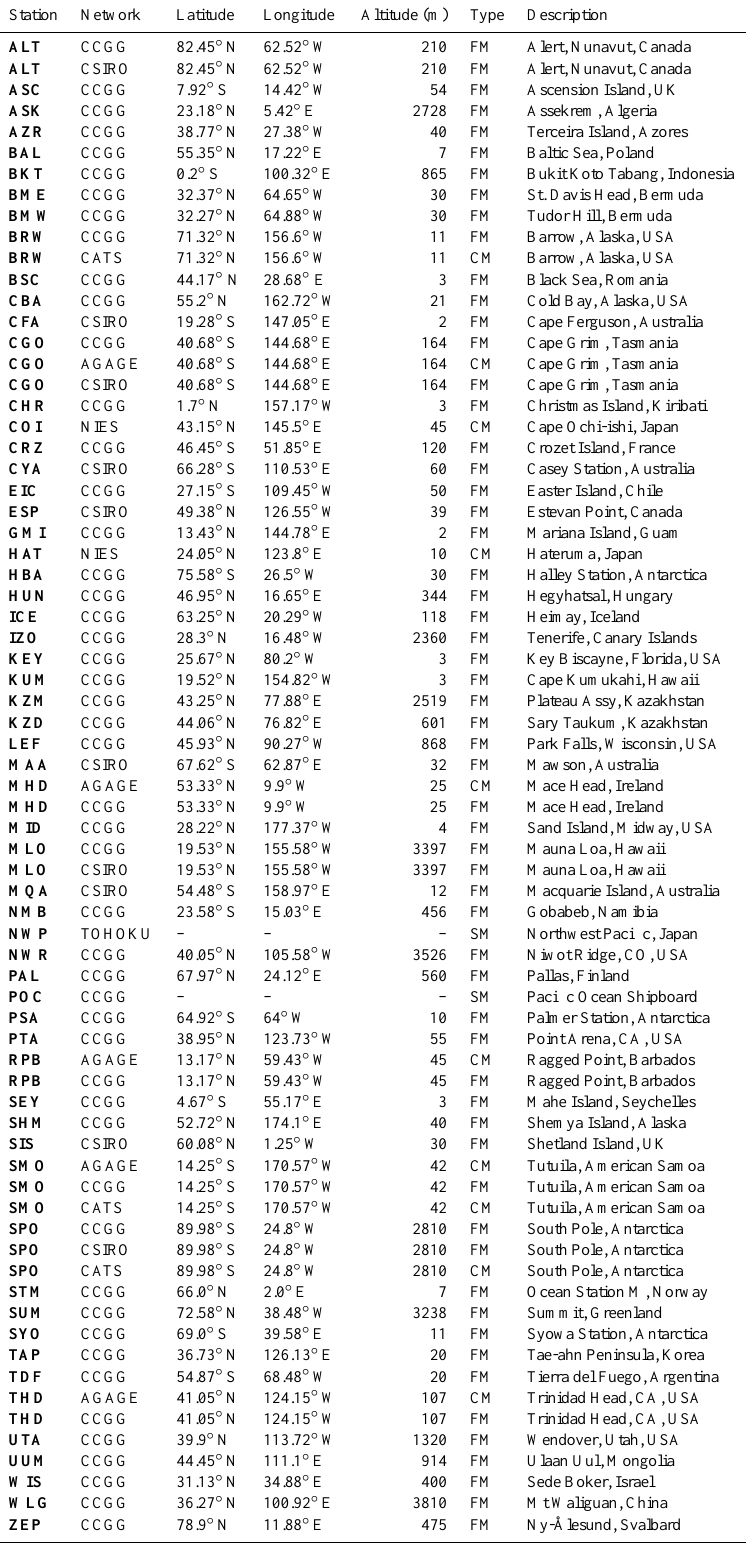
Table 1. Observation sites used in the inversions. Sites in bold type were included in the reference data set. (FM stands for flask measurement, CM for continuous measurement, and SM for ship-based flask